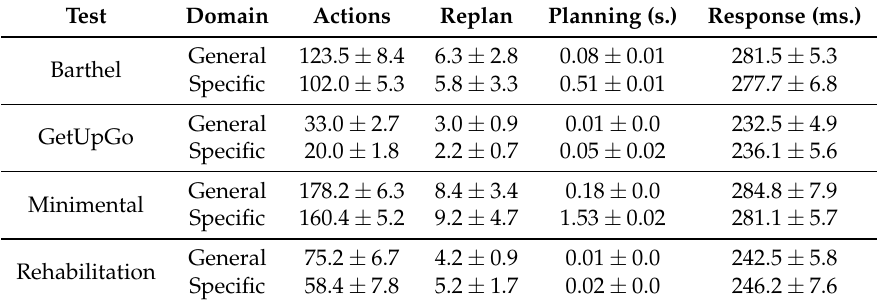
Table 4. Comparison of the general and specific domains in Barthel, Get up & Go, Minimental and